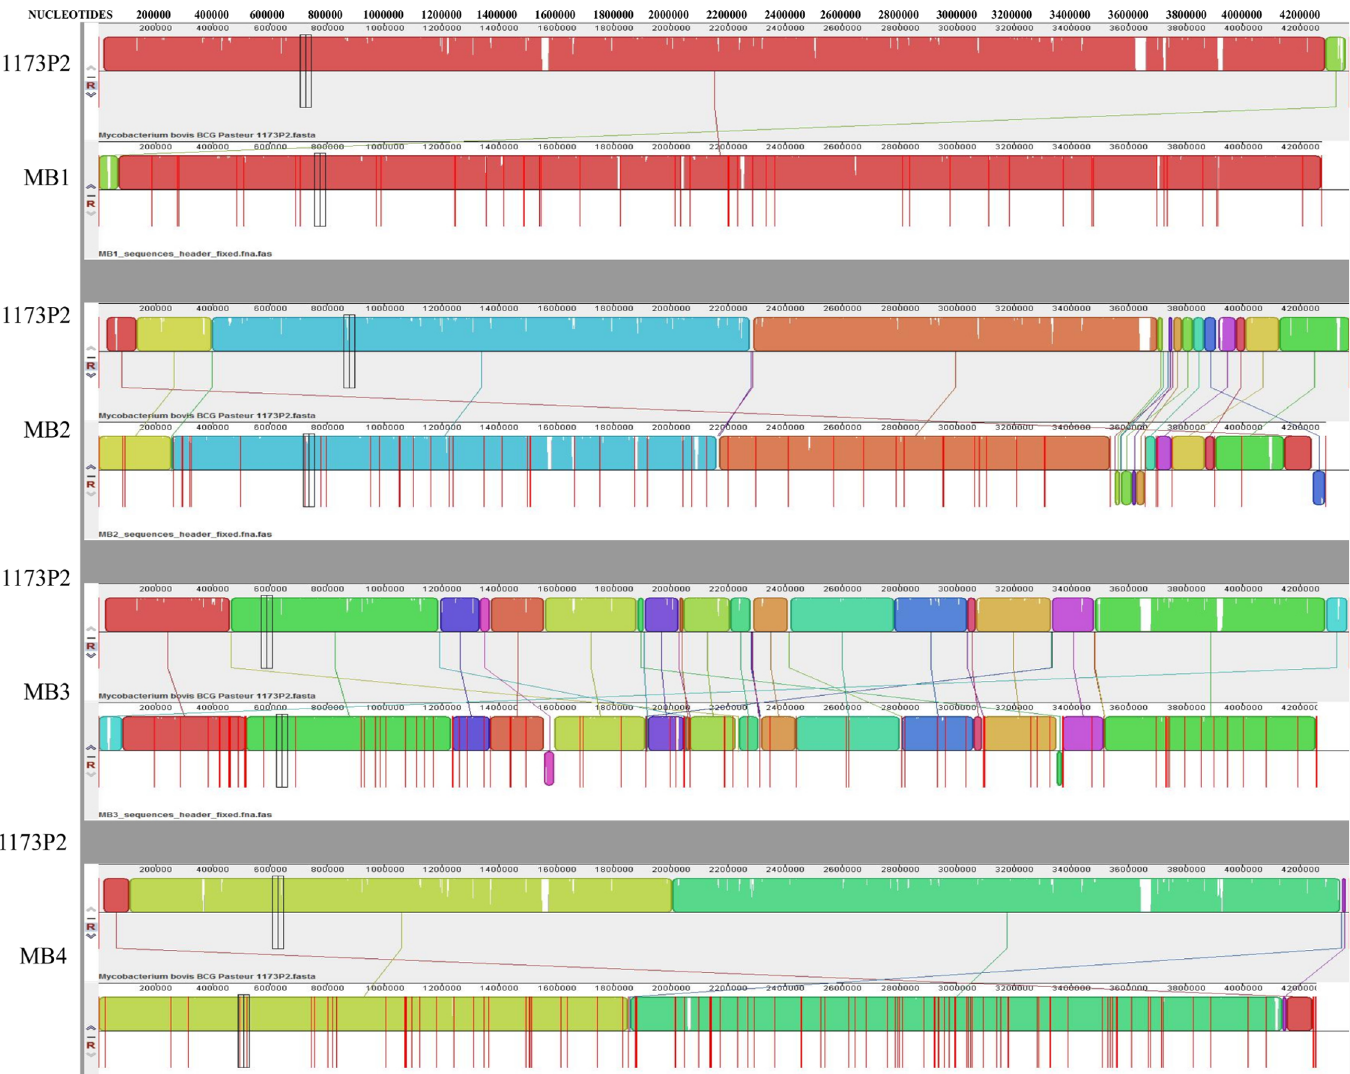
Fig 3. Comparative genomics of MB1-MB4 isolates. Genome sequence comparison between mycobacteria isolates MB1-MB4 and the most similar reported sequence of M . bovis BCG Pasteur 1173P2 using Differences program.